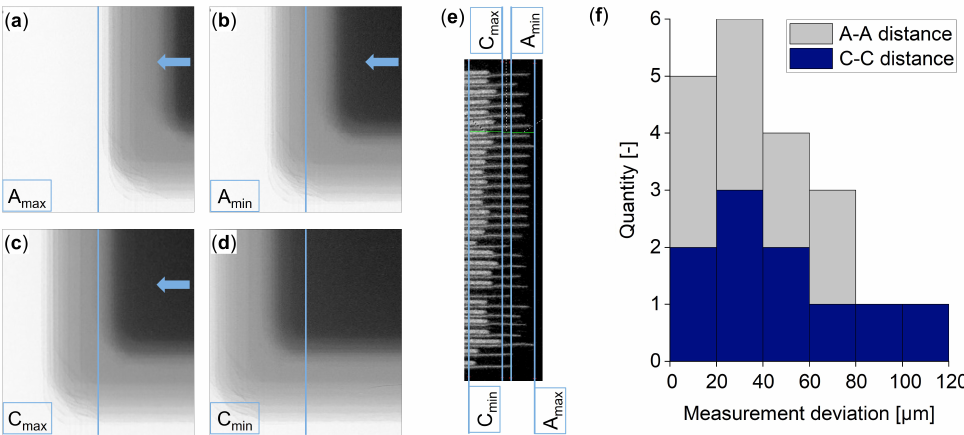
Figure 7. Determination of measurement deviation between a CT and a vertical coordination radiog- raphy: The X-ray images ( a – d ) illustrates the vertical coordination radiography in y 0 -direction by moving the ESC in x 0 -direction. The y 0 z 0 -plane of the central beam is illustrated with a blue line and is focused on A max in ( a ), A min in ( b ), C max in ( c ), C min in ( d ). Picture ( e ) shows an example CT slice and the manual measurement of the A-A and C-C distance. In the diagram ( f ) the measurement deviation between CT and a vertical coordination radiography of 10 ESC edges is plotted. The x-axis depicts the measurement deviations of the A-A and C-C distances in groups of 20 µ m and the quantity of measurements in a group can be read on the